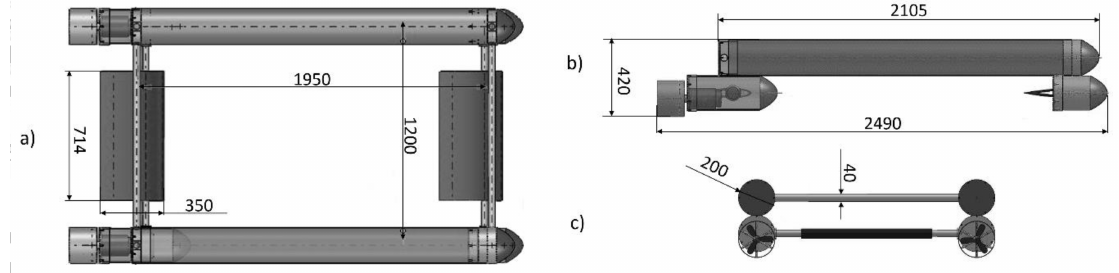
Figure 4. Dimensions of the robot. ( a ) Upper view. ( b ) Lateral view. ( c ) Rear